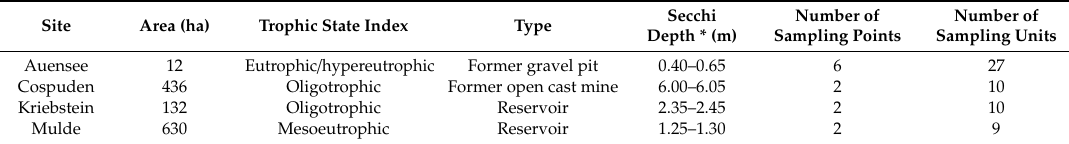
Figure 1. Location of the lake sites in Central Germany and sampling points (red dots) for water column measurements (satellite imagery: Sentinel 2A - RGB – 432 (17 / 04 / 2019); coordinate system of the map: ETRS89 / UTM zone 33N). Table 1. Characteristics of the investigated lake sites in Central Germany.